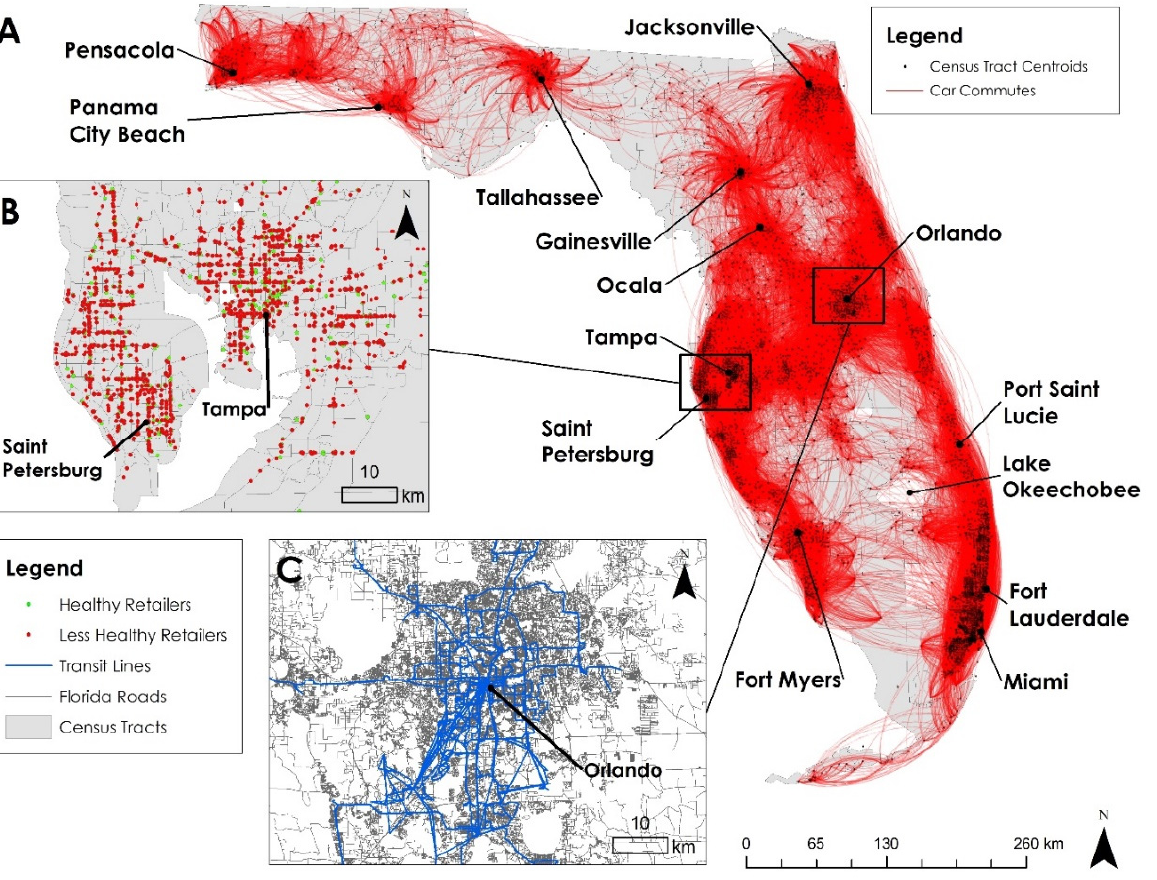
Figure 2. ( A ) Commuting flows by car between census tracts derived from the CTPP data. The line width is proportional to the number of commuters. For clarity, commuting trips were filtered if longer than 161 km (100 miles). ( B ) Healthy and less healthy food retailer locations in the Tampa Bay area. ( C ) Road network and transit lines in Orlando.